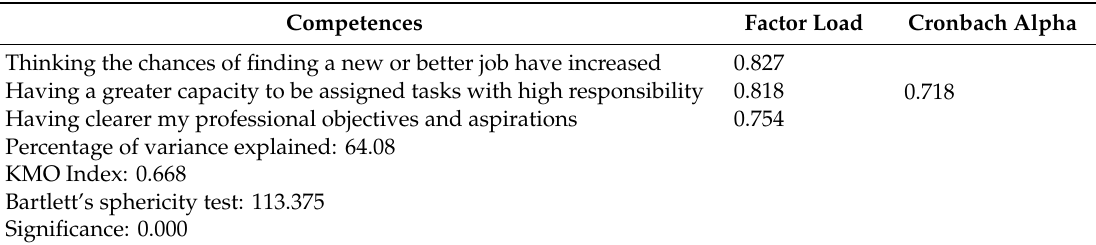
Table 5. Exploratory factor analysis results for employability